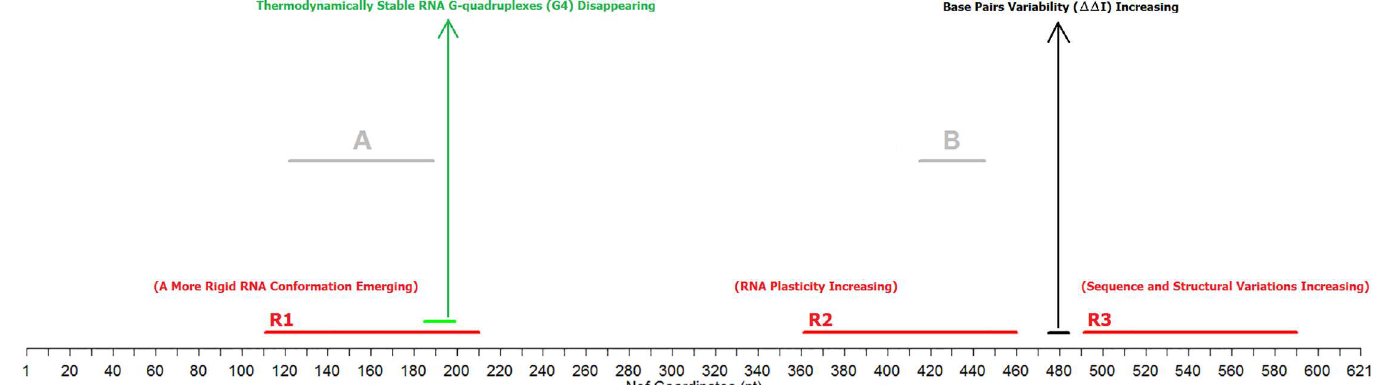
Fig 3. Mapping of this work’s major results regarding Nef RNA. Regions(R1, R2, and R3) in red correspond to locations with significant changes in CAF when comparingHistoric and Modern HIV-1 Nef sequences. (See Table 2 for exact coordinates.) The green region (sites 186–200)displayssignificantly reduced stable G4s. The region in black (sites 476–485) showed high diversity (quantified by the Doubly Differenced RelativeEntropy ΔΔ I ). The grey segment labeled A (segment 123–190) refers to the region coinciding with R1 identifiedby Westerhout et al. [34]; the gray label B points to segment 416– 446, referred to by Peleg et al. [11]. In Fig 3, the term “Sequenceand Structural Variations Increasing” refers to the observed simultaneous changes in the GC composition, CFE, and CAF of Modern